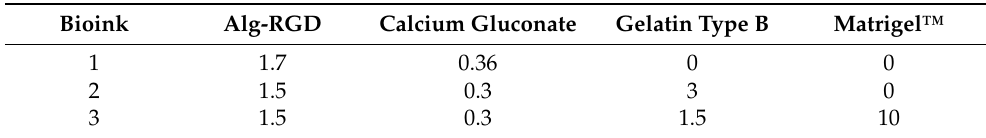
Table 1. Final composition of cell-laden, core bioink solutions.